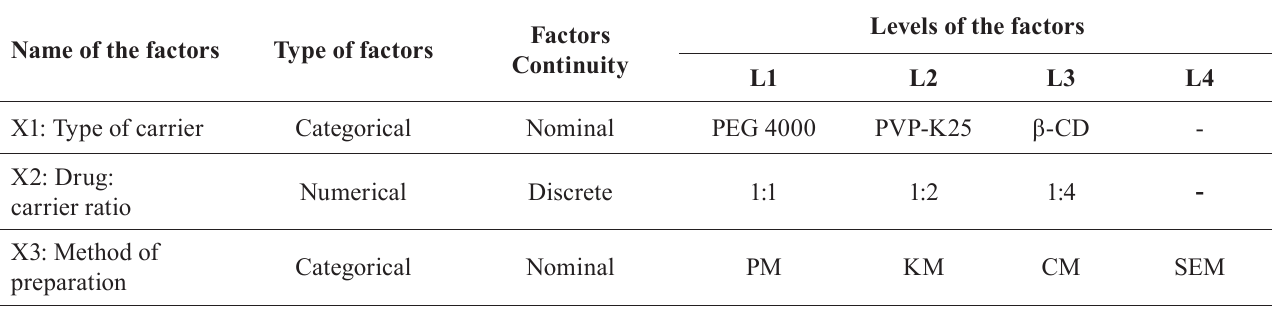
Name of the factors Type of factors